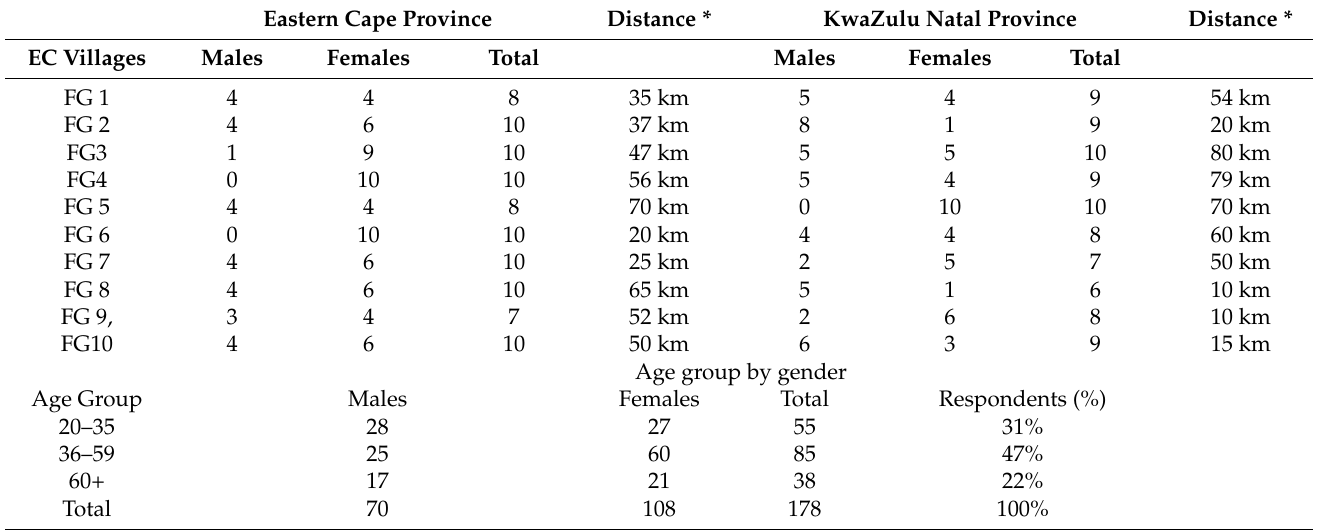
Table 3. Participant